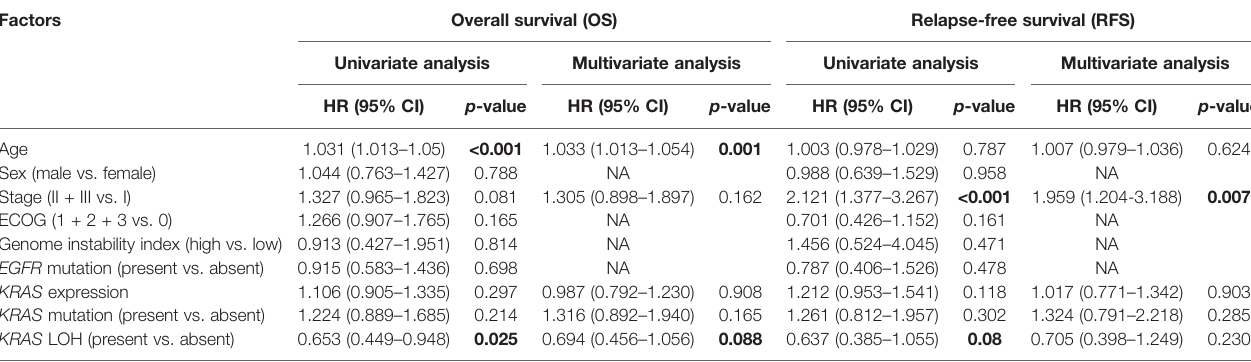
TABLE 3 | Univariate and multivariate Cox proportional hazards regression analyses of different prognostic variables for overall survival (OS) and relapse-free survival (RFS) in early-stage lung adenocarcinoma. Factors